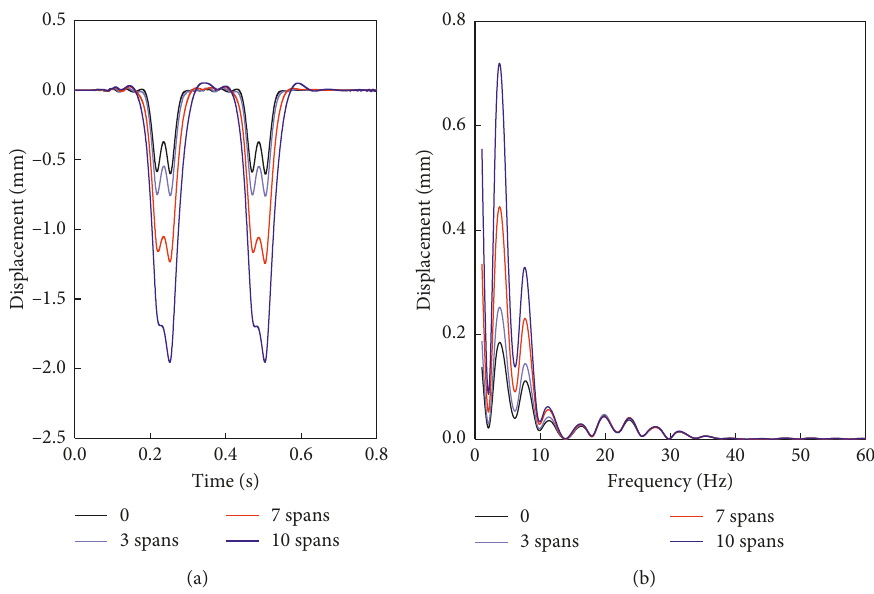
Figure 11: Rail displacements with different lengths of contact loss zone: (a) time domain and (b) frequency